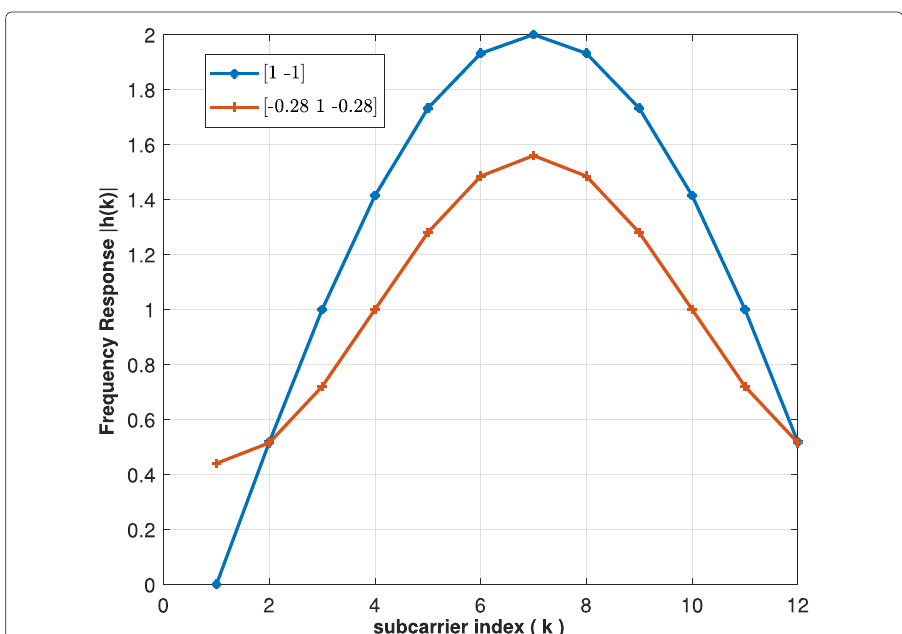
Fig. 5 Frequency response of commonly used spectrum shaping filters with 2-tap and 3-tap impulse